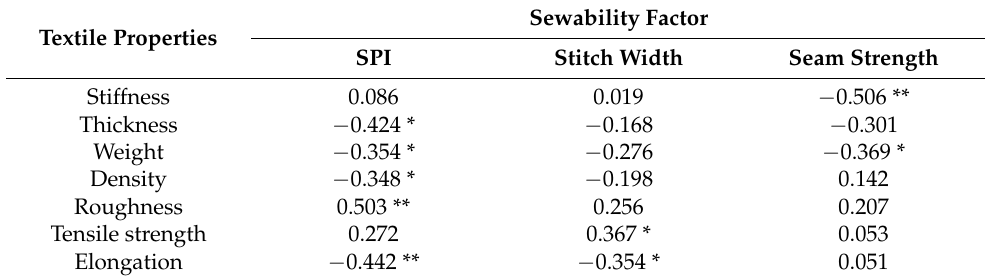
Table 11. Correlation coefficient between textile properties and sewability in the zigzag stitch. Textile Properties